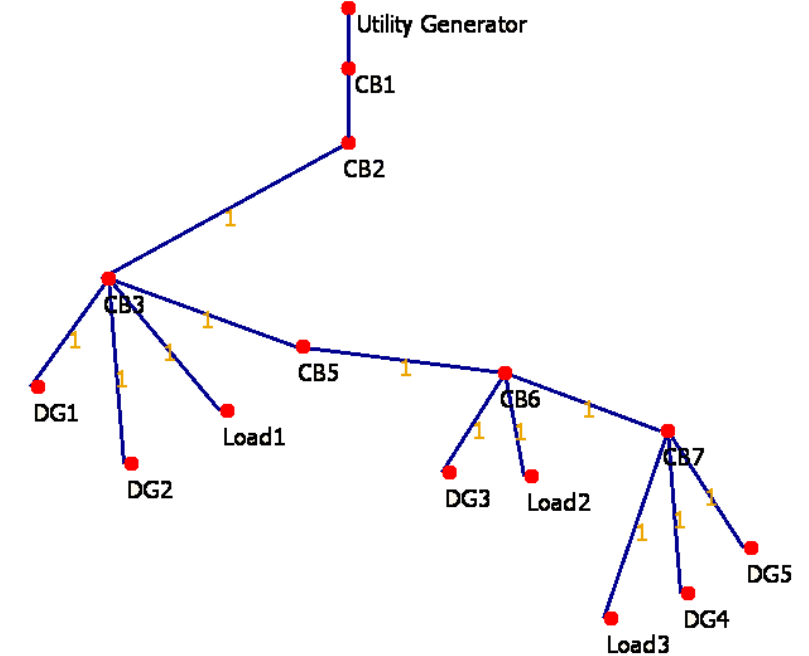
Figure 4. Modeling case Figure (b with graph theory).